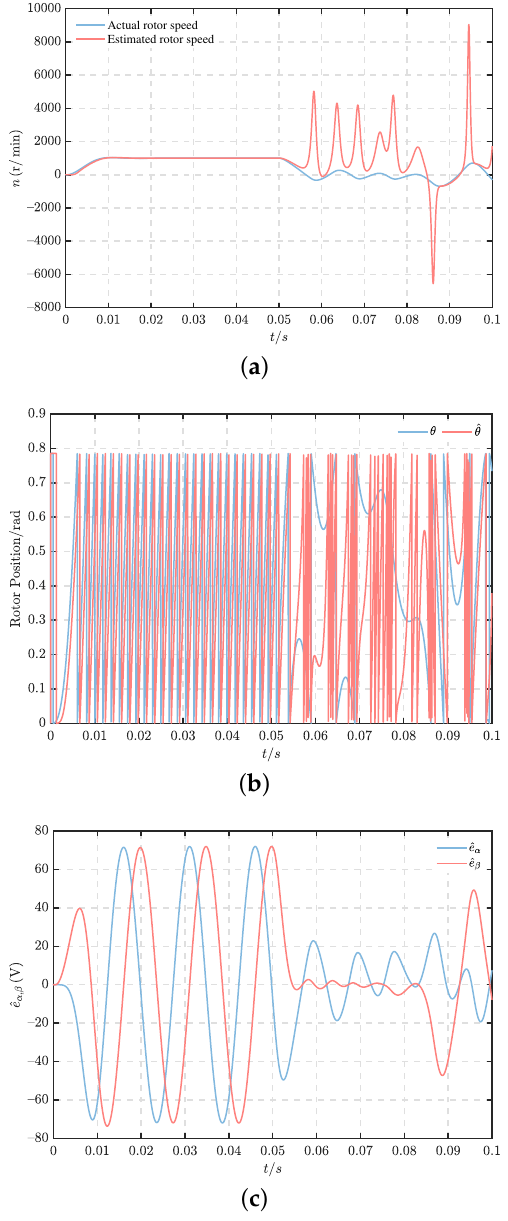
Figure 16. Responses of the simulation with conventional SMO combined with conventional PLL (forward and reverse). ( a ) Rotor speed. ( b ) Rotor position. ( c ) Estimation of the